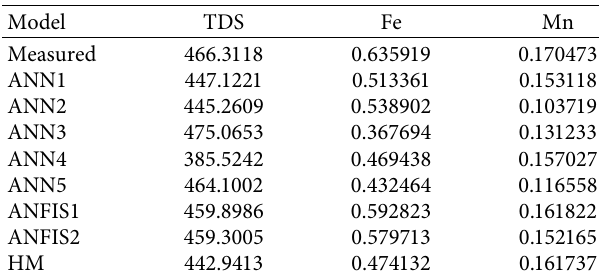
Figure 11: Taylor’s Diagram showing correlation, standard deviation, and Root Mean Square Error (RMSE, represented by blue contours) for (a) TDS, (b) Fe, (c) Mn, and (d) groundwater levels. Table 8: Standard deviation of data from different